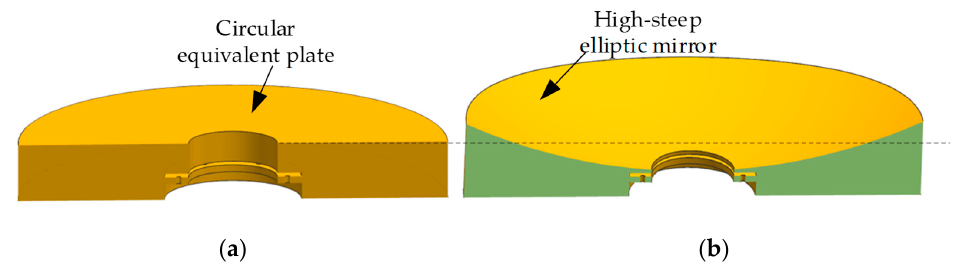
( c ) Figure 5. Typical lightweight unit: ( a ) triangular cell; ( b ) square cell; ( c ) hexagonal cell. 4. Optomechanical Design and Optimization of Mirror 4.1. Initial Structure Selection According to the equivalent method in Section 3, the thickness of the mirror can be selected to meet the bending stiffness requirements. In order to realize the high light- weight design of the mirror, it is necessary to select the support structure and optimize the lightweight structure. Commonly used mirror support methods include center support, back support, pe- ripheral support, etc. For high-steepness and very lightweight mirrors, the use of periph- eral support will cause gravity deformation and collapse along the optical axis. Center support and back support are two commonly used support modes for small- and me- dium-sized mirrors. In order to combine the advantages of the rapid manufacturing and